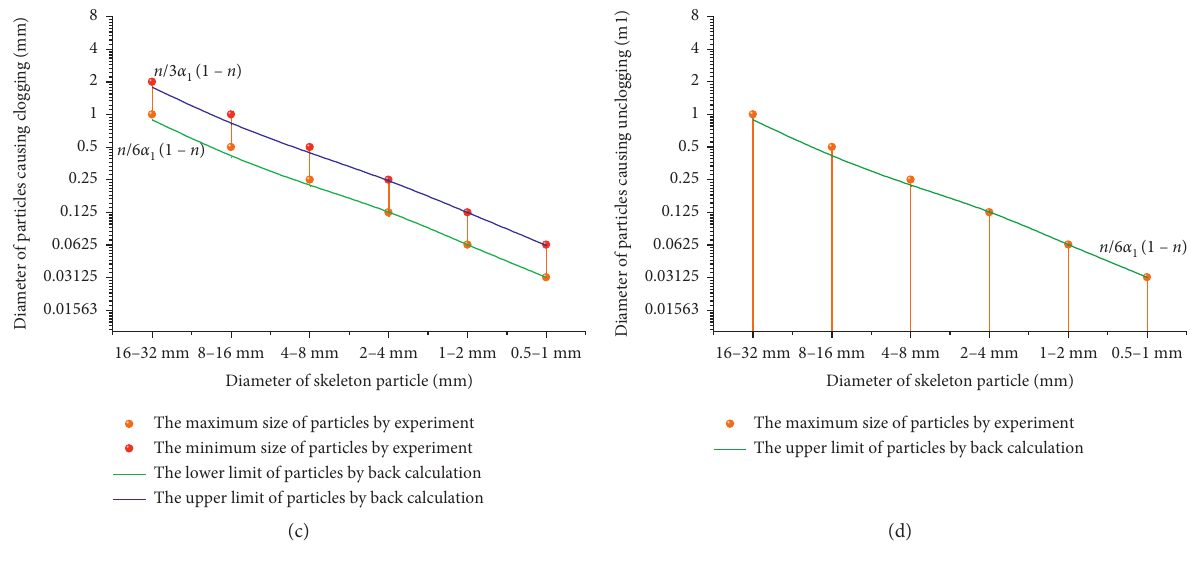
Figure 6: Clogging particle size for different soil media by calculation and experimental observation. (a) Surface-internal clogging pattern. (b) Surface clogging pattern. (c) Internal partial pore blockage pattern. (d) Unclogging pattern. Table 5: Criteria for determining the clogging patterns of unisize-graded soils. d e / D ea Surface clogging Surface-internal clogging Internal partial pore blockage